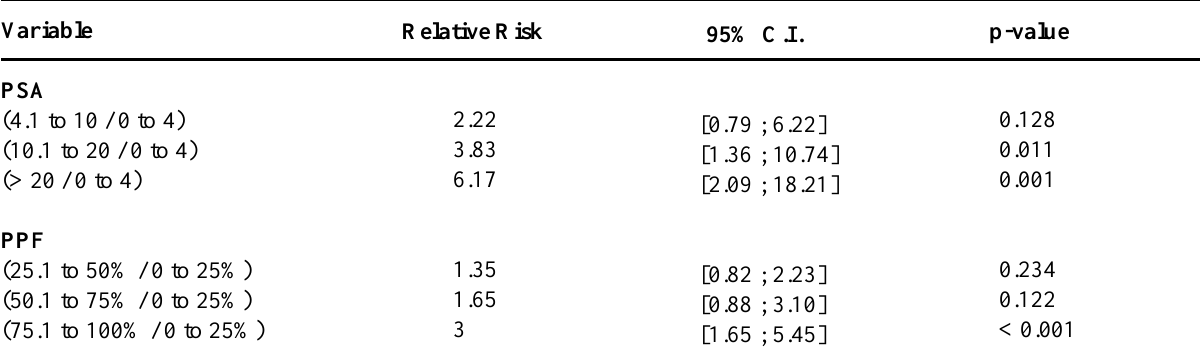
Table 6 – Analysis of relative risk for PSA and percentage of positive fragments (PPF) in the Cox regression